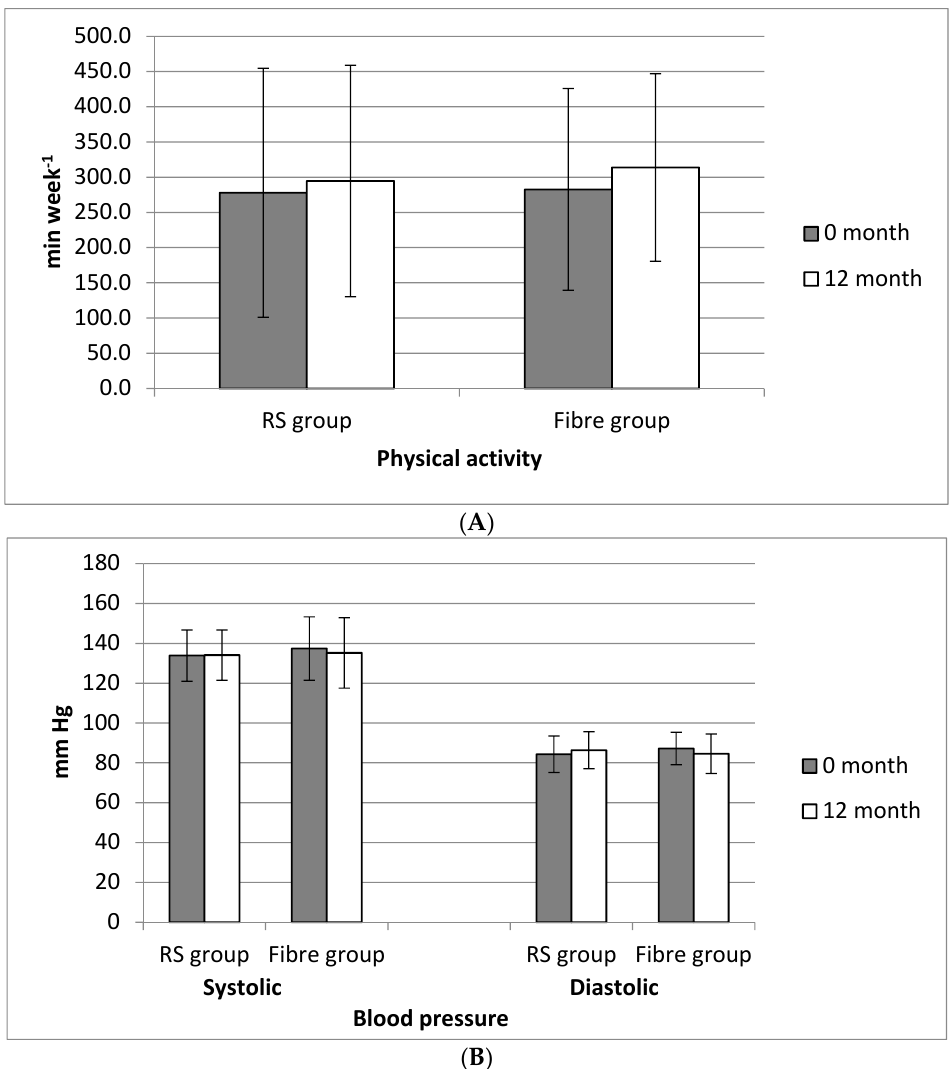
Figure 3. ( A ) Physical activity and ( B ) blood pressure in the subject groups (RS group and Fibre group), at the beginning and after 12 months of lifestyle intervention.